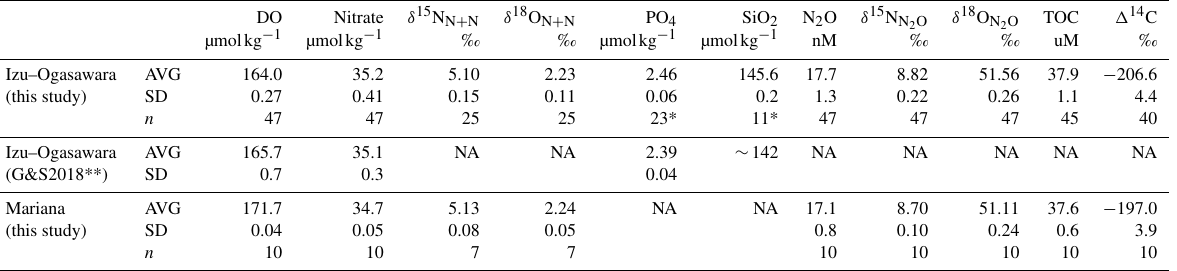
Table 2. Summary of analyses. AVG: average.